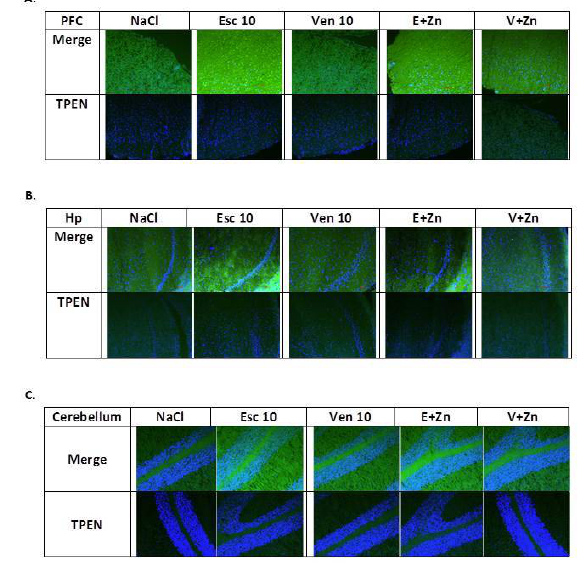
Figure 3. The representative images of the effects of antidepressants (Esc, Ven) and Zn supplementation on intracellular zinc concentration in the prefrontal cortex (PFC, ( A )) and hippocampus (Hp ( B )), and cerebellum ( C ) of rats subjected to the OB + ZnD model using fluorescent Zinpyr-1 (ZP-1) staining. Sections were double-stained with DAPI (blue) to reveal cell nuclei and ZP-1 (green) to detect fluorescent intracellular Zn 2+ . Merged images include ZP-1 and DAPI (upper panel) or TPEN/ZP-1 and DAPI (lower panel) in the PFC ( A ), Hp ( B ), and cerebellum ( C ). ZP-1 fluorescence is mostly absent in TPEN-treated sections, indicating high specificity of ZP-1 for Zn 2+ . Scale bar = 50 µ M.